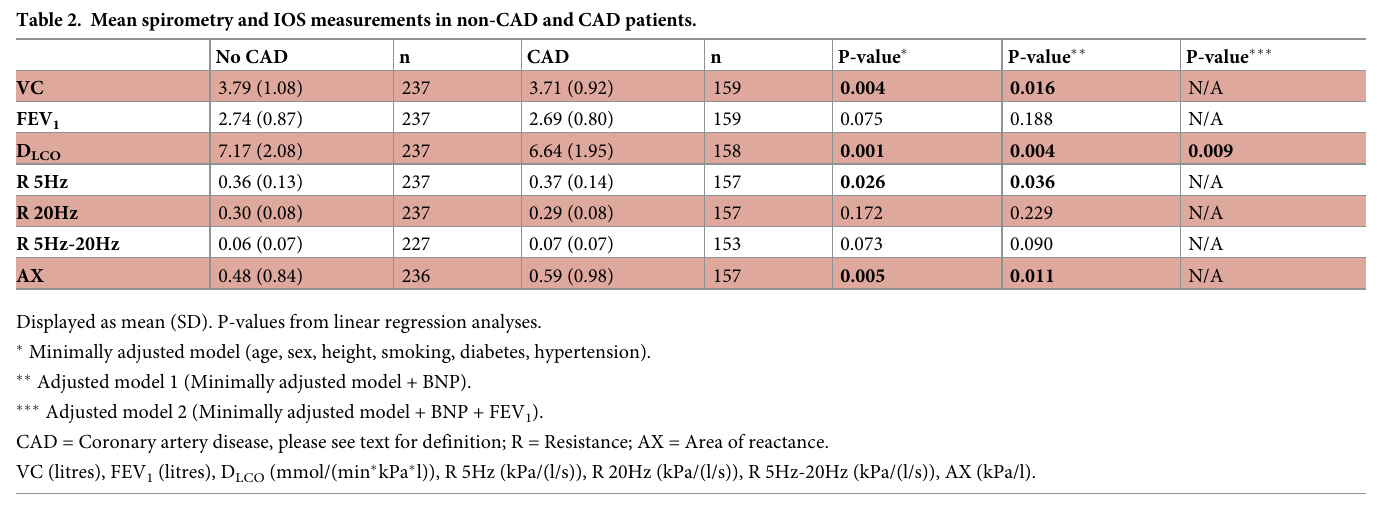
A total of nine proteins were significantly increased in subjects with a combined diagnosis of airflow obstruction and CAD compared with those without a combined diagnosis: VSIG2 ,